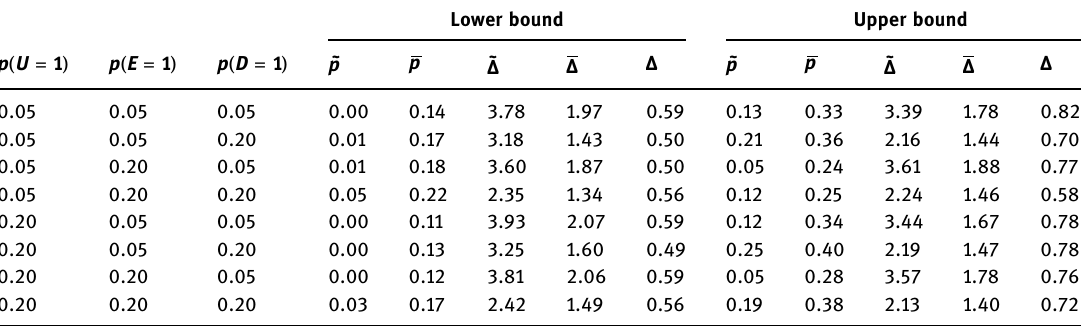
Table 3: Simulation results with σ 3 = . p ˜ and p are the proportions of times that AS ’ bounds and our bounds are tighter than DV ’ s bounds, respectively. Δ˜ , Δ and Δ are the mean absolute distance between the log of the bound and the log of the true risk ratio for AS ’ bounds, our bounds and DV ’ s bounds, respectively Lower bound Upper